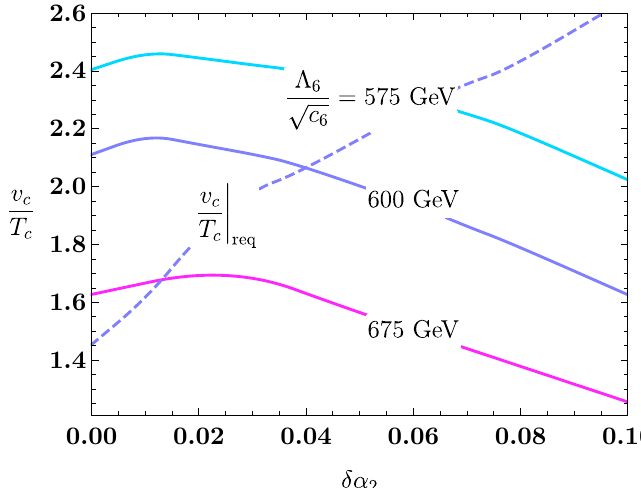
p c 6 = 575 ; 600 ; 675 GeV. The p c 6 = 600 GeV.